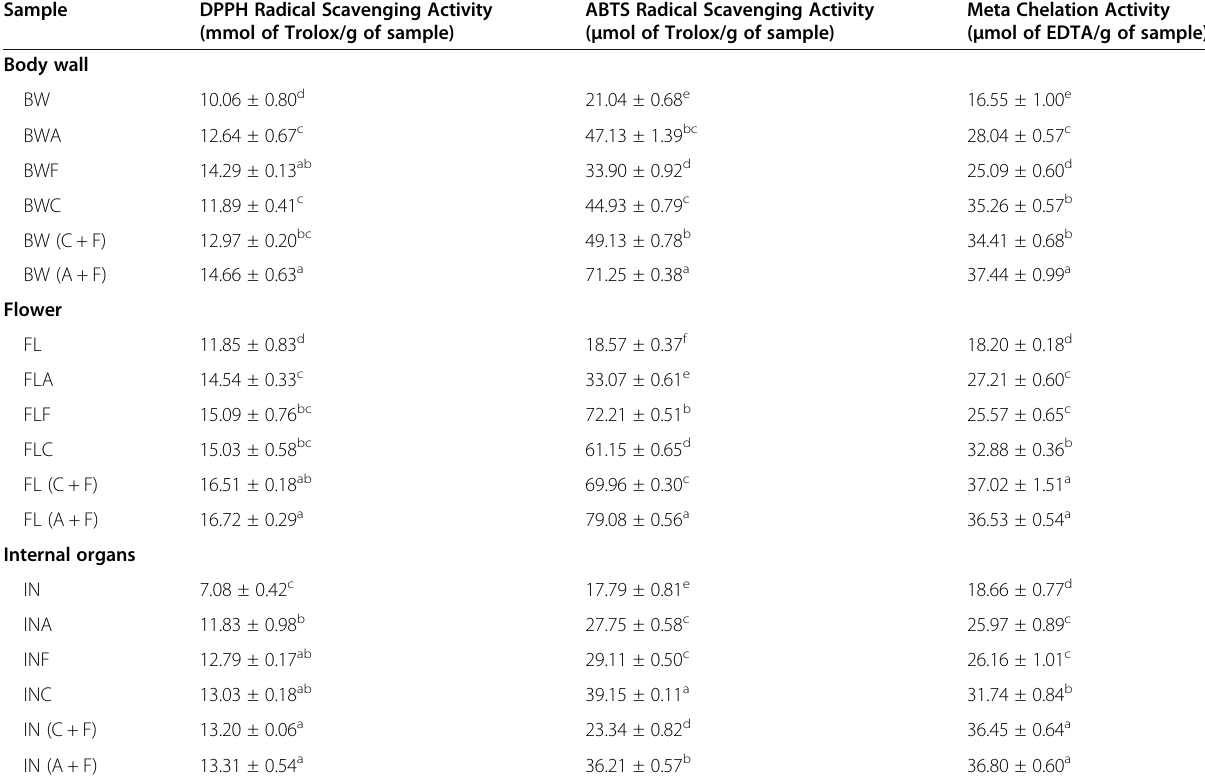
Table 1 In vitro antioxidant activity of sea cucumber protein hydrolysates